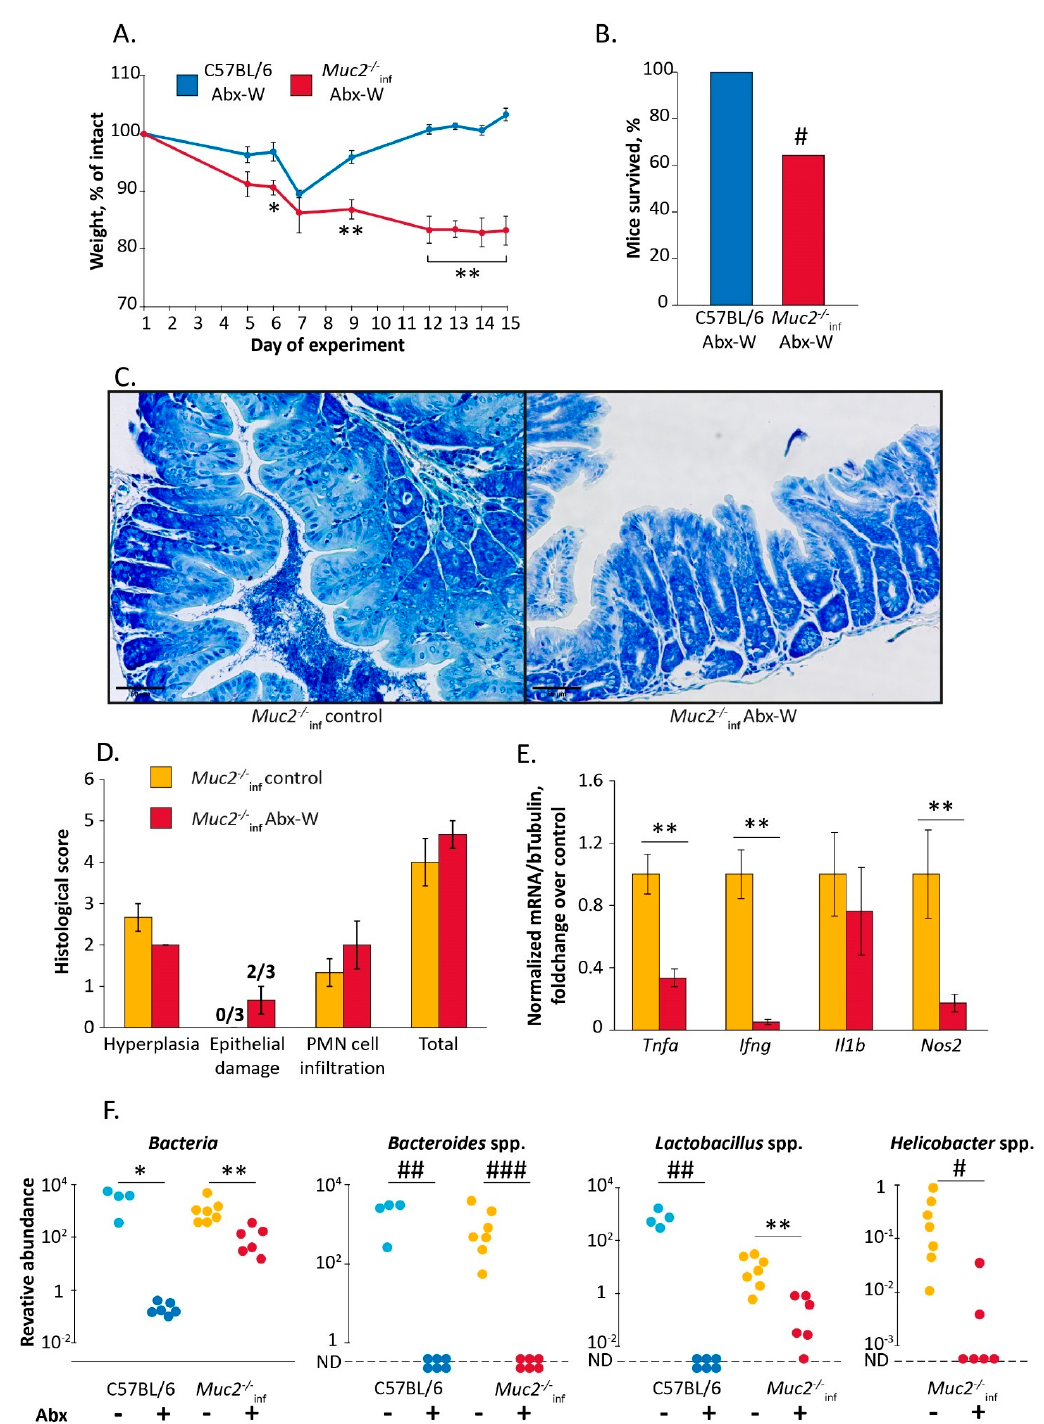
Figure 1. The antibiotic treatment induced mortality of Muc2 − / − mice. ( A ) Body weight dynamics during the antibiotic treatment. *, **—“C57BL/6 Abx-W” vs. “ Muc2 − / − inf Abx-W”, p < 0.05, p < 0.01, Mann–Whitney u-test. ( B ) Survival rate. #—“C57BL/6 Abx-W” vs. “ Muc2 − / − inf Abx-W”, p < 0.05, Fisher Exact test. ( C ) Azur-II-eosin-stained colonic sections of Muc2 − / − mice (treated with the antibiotics and control group). Scale bar = 50 µ m. ( D ) Histological score of inflammation in colon of Muc2 − / − mice. ( E ) Gene expression in colon tissue normalized on beta Tubulin (Tubb5) gene. **—differences between groups p < 0.01, Mann–Whitney u-test. ( F ) Relative abundance of the gut bacteria in feces on the day 15, normalized on Mus musculus 28S rRNA DNA. *, **—differences between groups p < 0.05, p < 0.01, Mann–Whitney u-test. #, ##, ###—differences between groups p < 0.05, p < 0.01, p < 0.001, Fisher Exact test. ND—not detected. Experimental groups: “Abx-W”—treatment with the antibiotics by adding in drinking